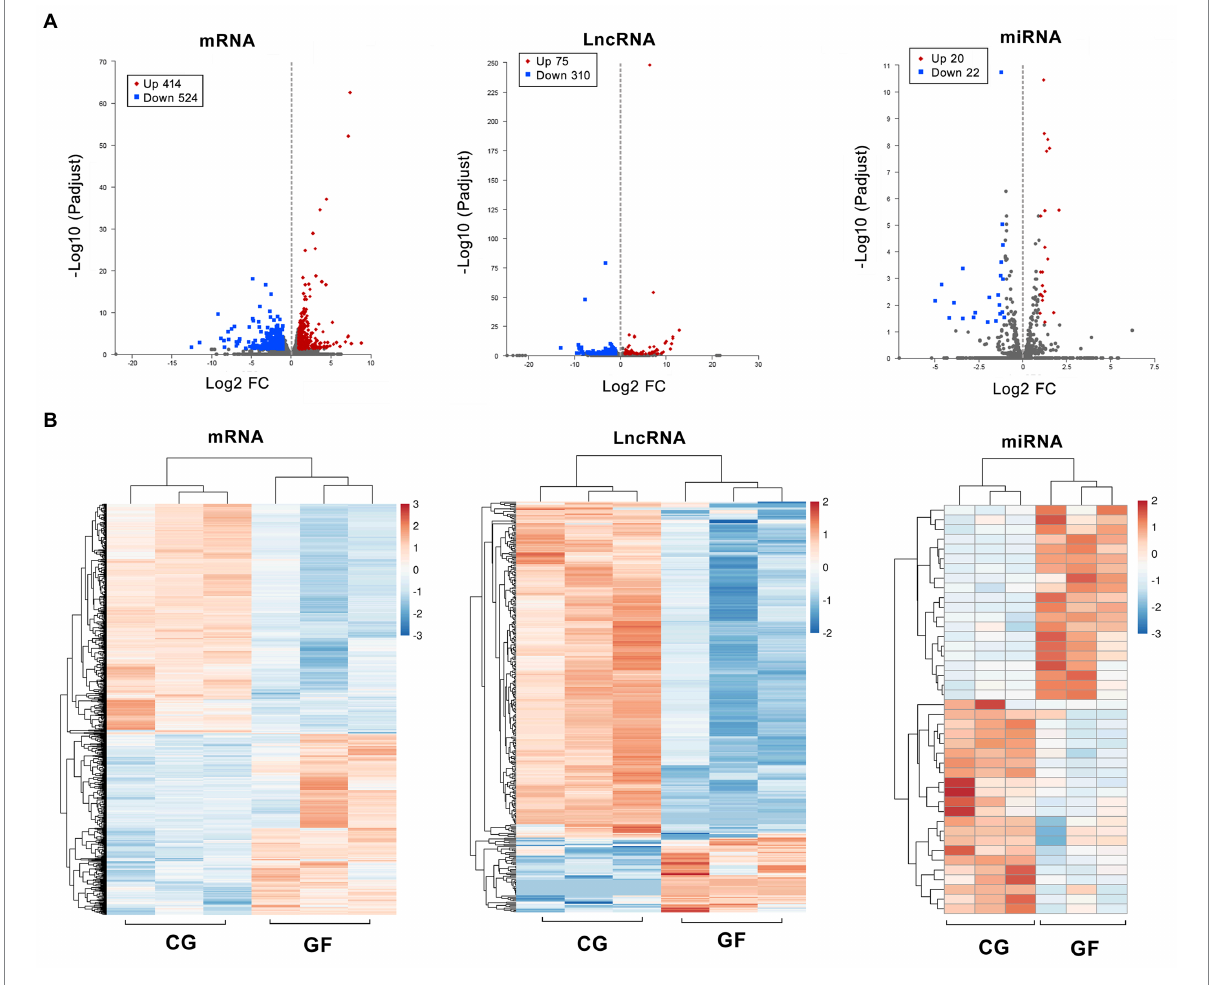
FIGURE 2 Differentially expressed transcripts and gene profiles in GF and CG pigs. (A) Volcano plots showing significantly different expression levels of different genes (mRNA) and transcripts (lncRNA and miRNA) between groups. (B) Clustering analysis of all differentially expressed genes and transcripts. The heatmap is based on expression values with log 2 | (fold change) | ≥ 1 and Padjust <